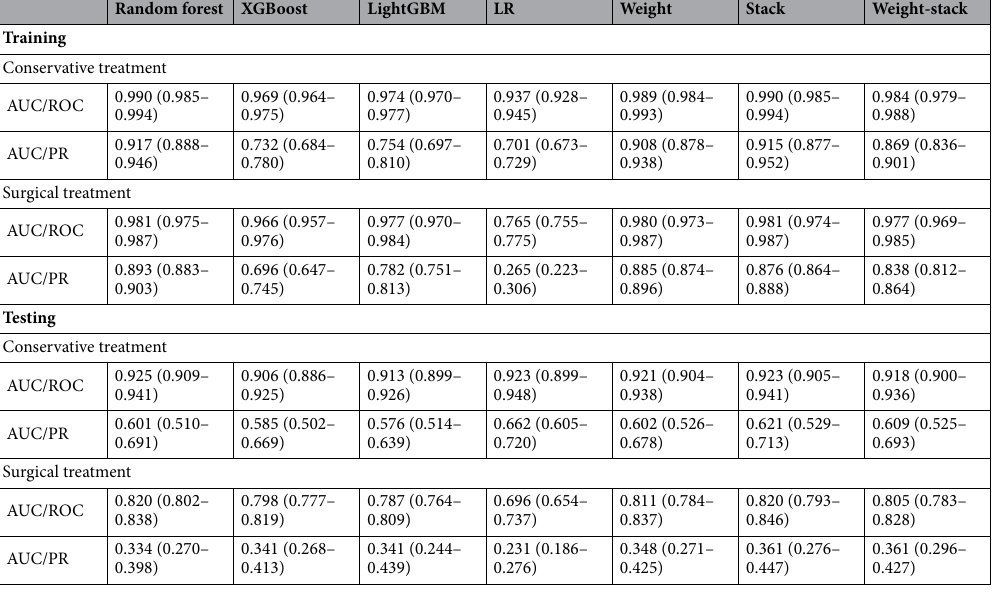
Table 1. AUC/ROC and AUC/PR in conservative versus surgical treatment groups (from s.d.).